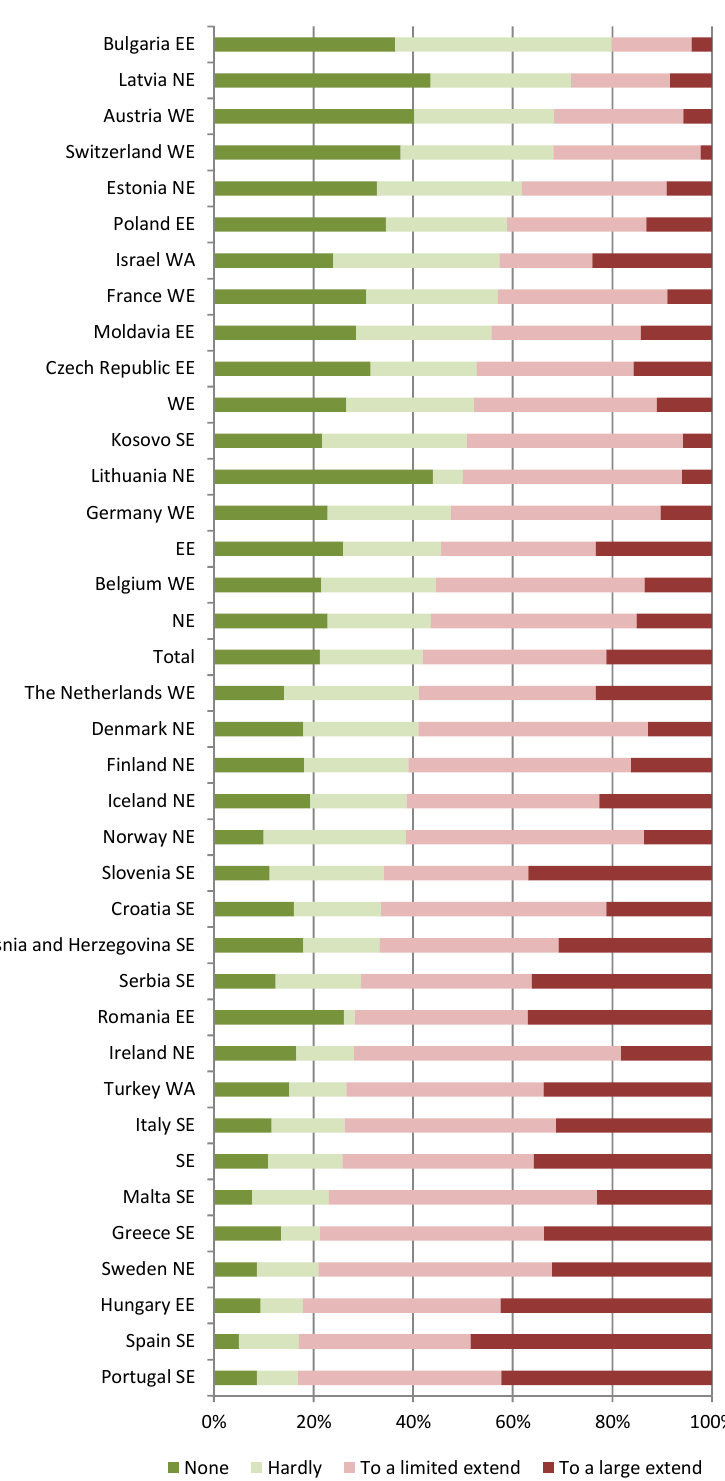
Figure 1. Experience of limitations related to the building or practice infrastructure.